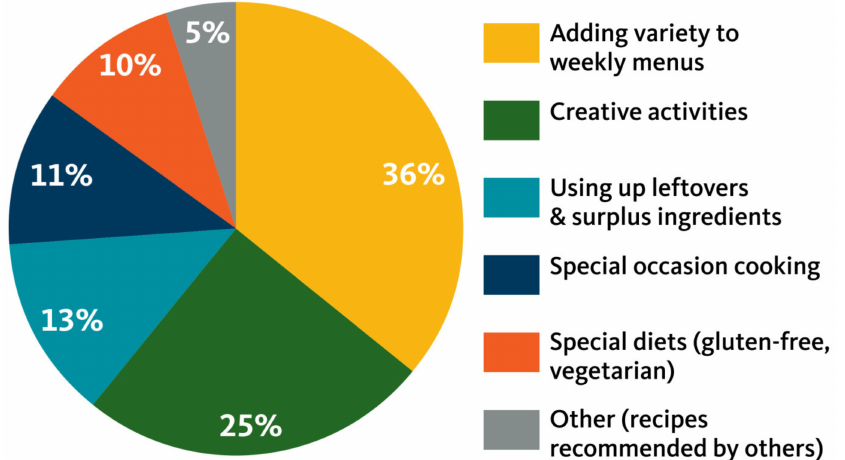
Figure 2. Motivation for finding